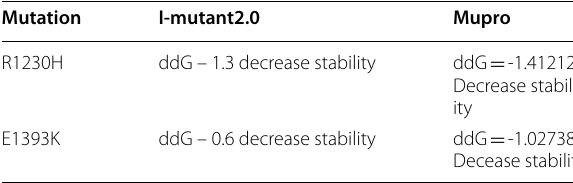
Table 9 Sequence‑based stability predictions